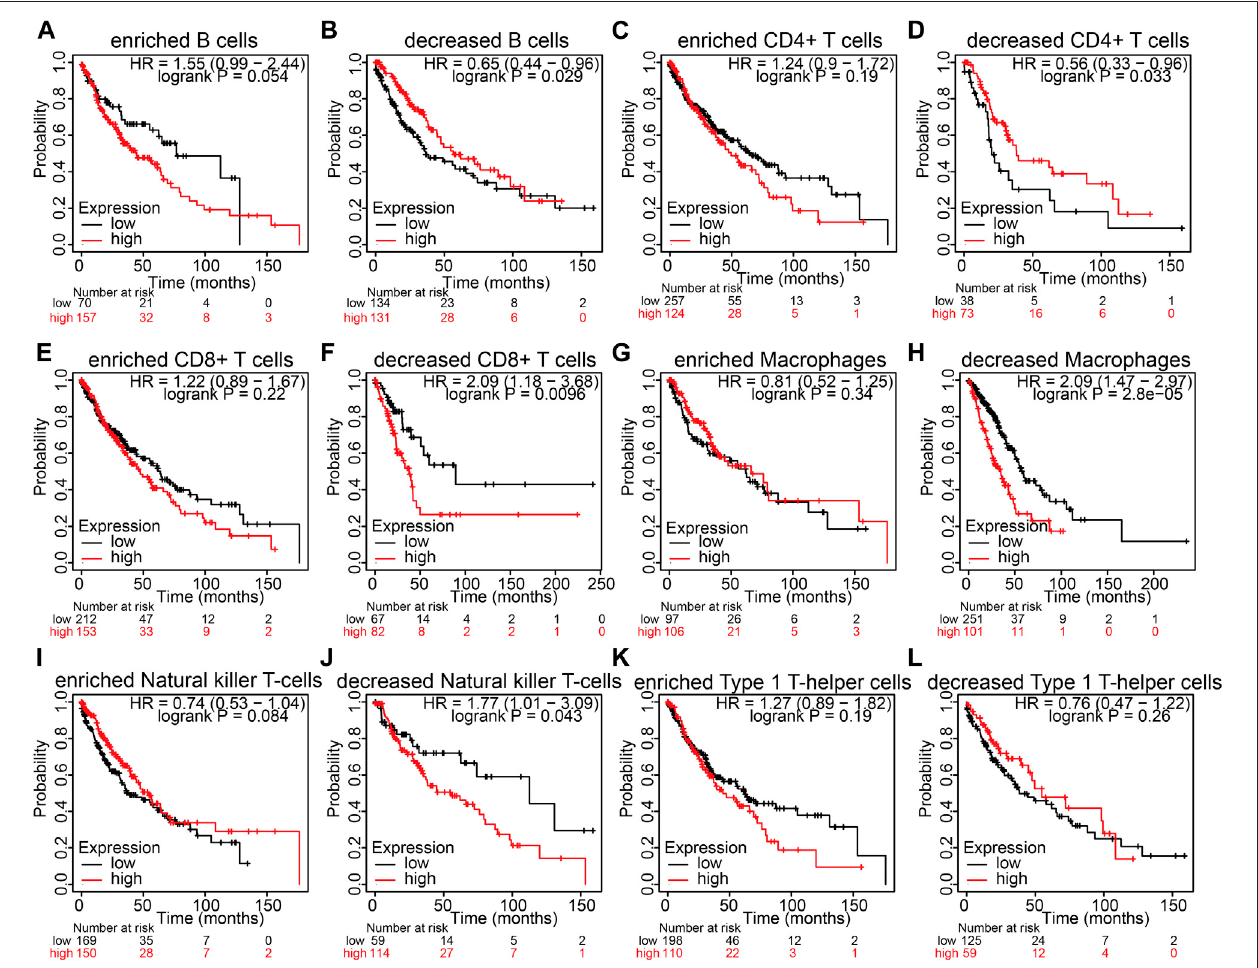
FIGURE 8 | The prognosis analysis based on the expression of NCAPG in different immune cell subgroups in NSCLC. (A – L) Correlation between NCAPG expression and OS in different immune cell in fi ltration groups in LUAD patients. * p < 0.05, ** p < 0.01, *** p < 0.001.